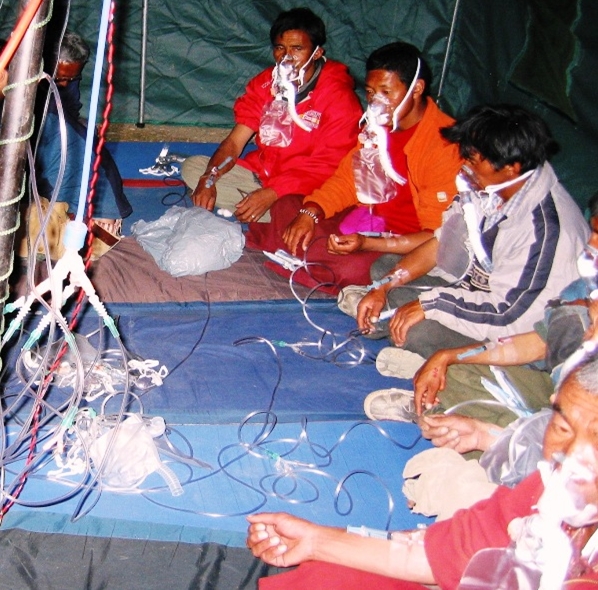
Hyperoxia in a tent at 4450 m. on the Tibetan plateau, near Korzok village in Ladakh, India.The subjects were exposed to hyperoxia for 1 hour. Note the venous catheters in place on the forearms to allow the drawing of blood for the post hyperoxia samples. This maneuver resulted in significant changes in gene expression in white blood cells.